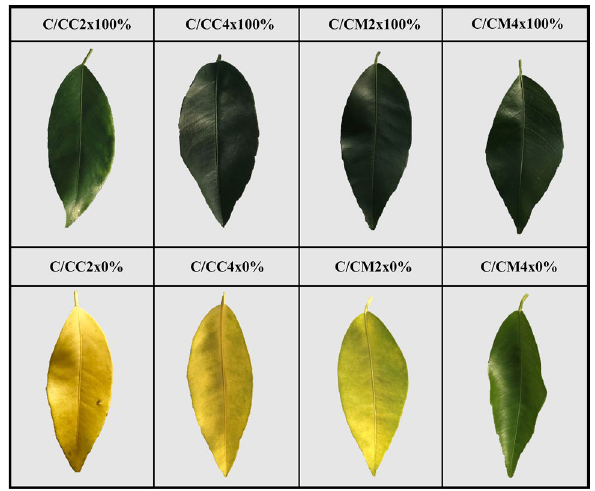
Figure 1. Leaf damages of common clementine scion grafted onto different rootstocks. Leaf damages of common clementine scion grafted onto diploid (C/CC2x) and doubled diploid (C/CC4x) Carrizo citrange and diploid (C/CM2x) and doubled diploid (C/CM4x) Citrumelo 4475 rootstocks grown in nutrient reference solution (100%) and without nutrient solution